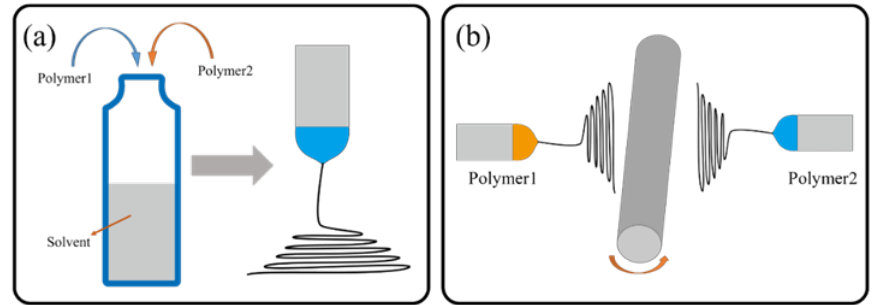
Figure 7. Preparation of air-filter membrane by electrospinning of various polymers: ( a ) blending of various polymers; ( b ) preparing a filter membrane by multiple jets. Table 3. Multipolymer air-filtration membranes prepared by common electrospinning.